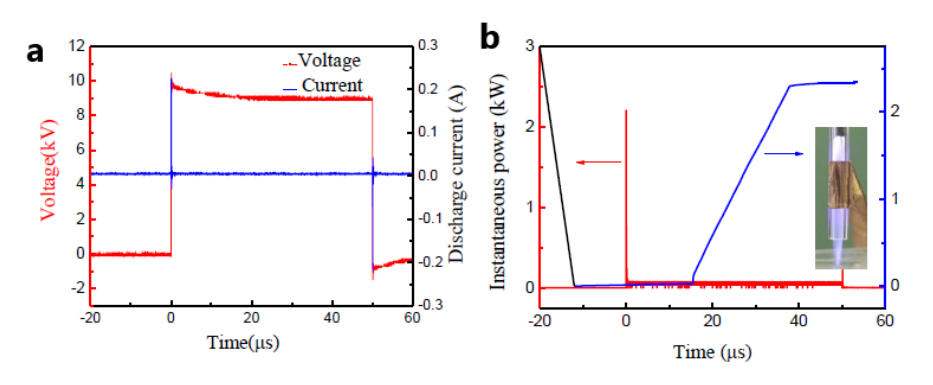
Figure 3. ( a ) Voltage and current discharge waveforms and ( b ) instantaneous power and energy waveforms of the P-Jet (the inset shows the discharge image of P-Jet).